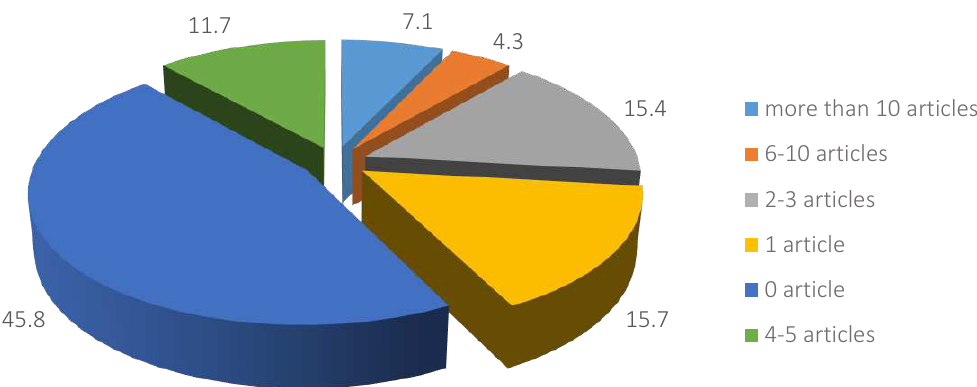
Figure 2. Percentage of scientists who have articles in Ukrainian scientific journals indexed by Web of Science and (or) Scopus